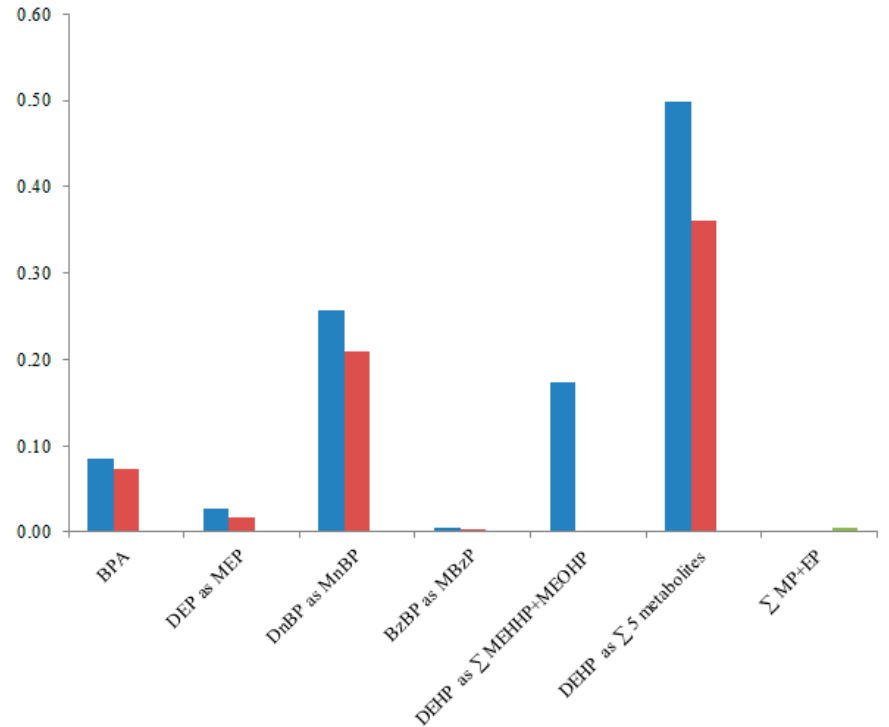
Figure 1. HQs calculated in the present study. Blue columns: HQs calculated using ng/mL; red columns: HQs calculated using µ g/g creatinine ; green columns: for parabens only, HQ calculated using EDI and ADI.